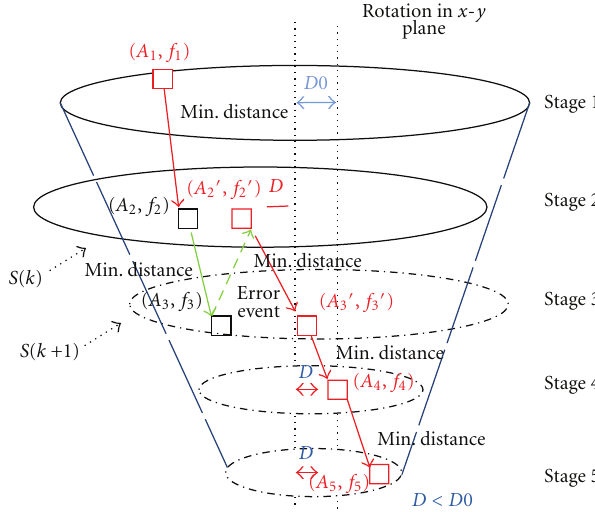
Figure 8: Results of neural network training for third stage.